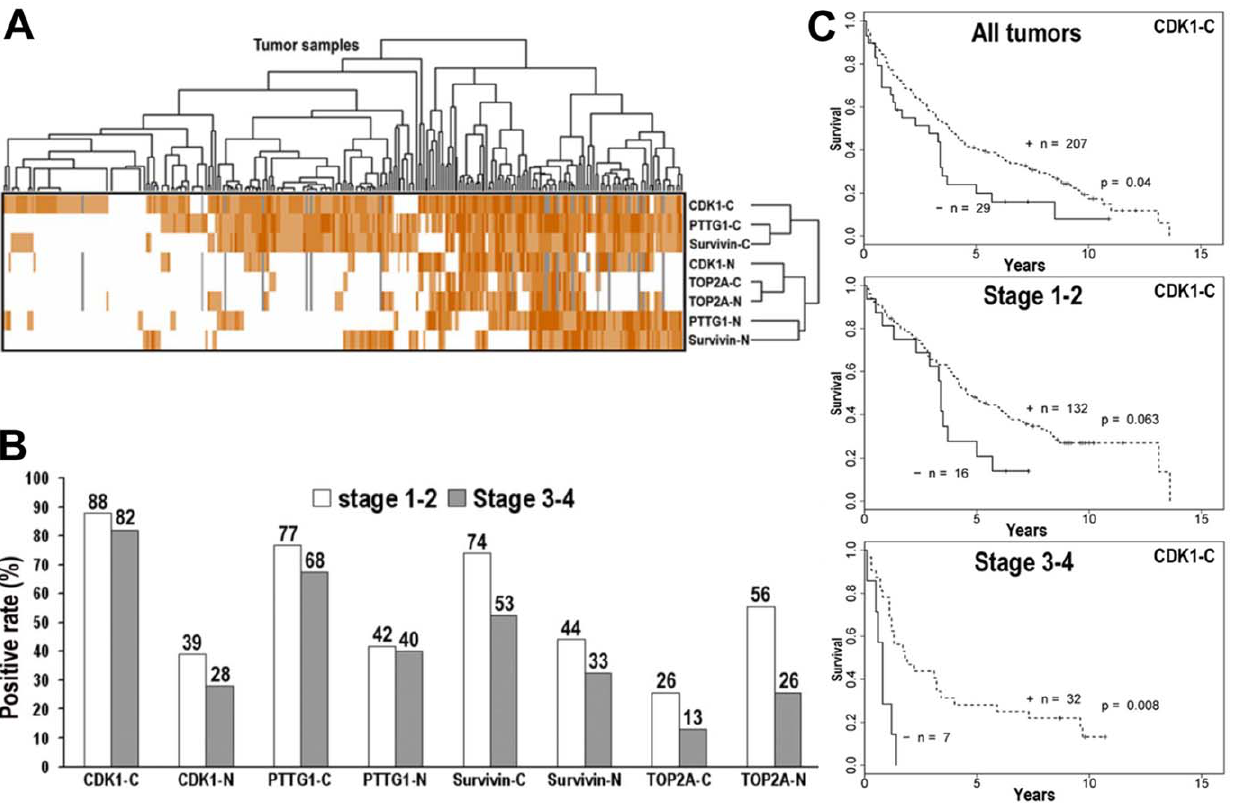
Figure 4. The associations of staining outcomes with tumor samples, clinical factors and patient survival. A. The hierarchial clustering for both antibodies and tumors using Cluster 3.0 and Java TreeView. B. The positive rates of CDK1, PTTG1, Survivin and TOP2A in early stages (1–2) and advanced stages (3–4). C. Kaplan-Meier survival analysis for cytoplasmic CDK1 staining pattern in NSCLC. The permutation test was used to calculate the p value for all tumors and tumors by stage. CDC25 dual-specificity phosphatases are key regulators of cell cycle progression through activation of CDKs by dephosphory- lating CDKs at threonine 14 and tyrosine 15, two critical amino acid residues leading to subsequent association of CDKs with their associated cyclins. Three homologs exist in mammals: CDC25A, CDC25B, and CDC25C. CDC25A [22,23,24] and CDC25B